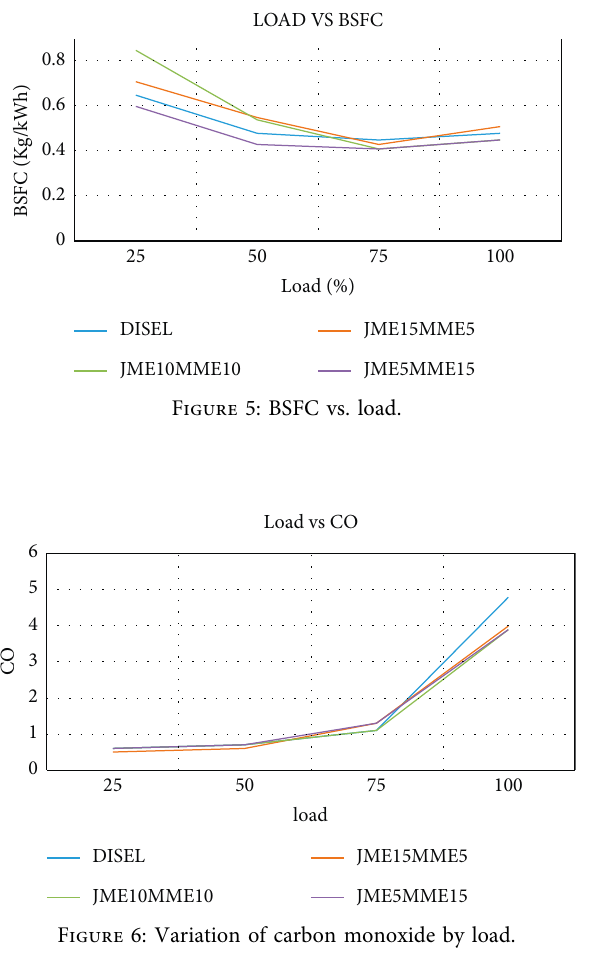
Figure 6: Variation of carbon monoxide by load.